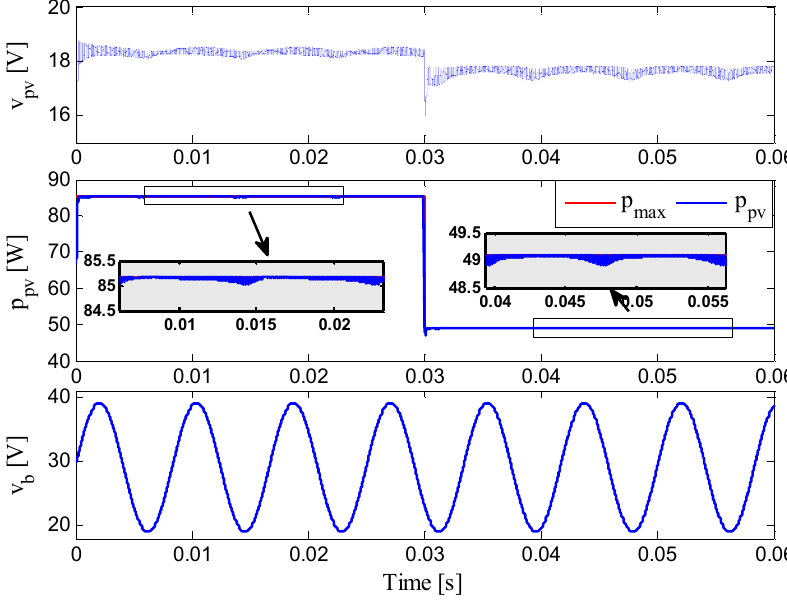
Figure 14. System response with load perturbation.